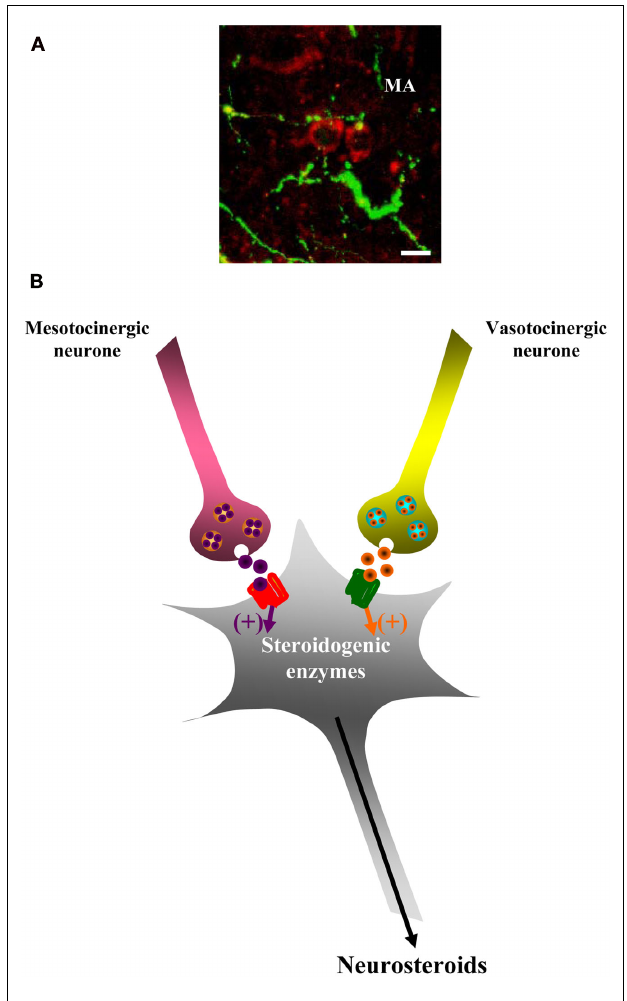
FIGURE 3 | Effect of vasotocin (AVT) and mesotocin (MT) on neurosteroid biosynthesis. (A) Immunohistochemical localization of P450 C17 -like immunoreactivity (red) and AVT-like immunoreactivity (green) in the medial amygdala (MA) of the frog brain. AVT-containing nerve endings are located in close proximity of P450 C17 -expressing neurons. For details regarding antibodies and immunohistochemical procedures, see reference by Do Rego et al. (2006). In brief, polyclonal antibodies raised in rabbit were used to label 3 β -HSD-or P450 C17 -containing neurons, and a mouse monoclonal antibody was used to label AVT-immunoreactive fibers. Scale bars: 10 μ m. (B) Schematic drawing depicting the effects of AVT and MT on steroidogenic neurons. AVT acting through aV1a-like receptor, and MT acting through an MT receptor, stimulate the biosynthesis of 17OH- Δ 5 P, DHEA, 17OH-P, and